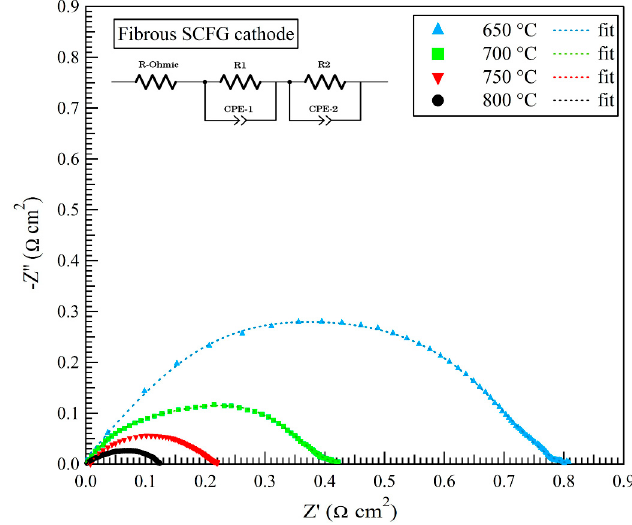
Figure 5. Nyquist impedance spectrum of the pure fibrous SCFG cathode and SDC-infiltrated SCFG electrodes with various amounts of SDC nanoparticles on an SDC electrolyte. Table 1. Values of total polarization resistance and fitting parameters of EIS spectra for the various fibrous cathodes in the 650–800 °C temperature range.